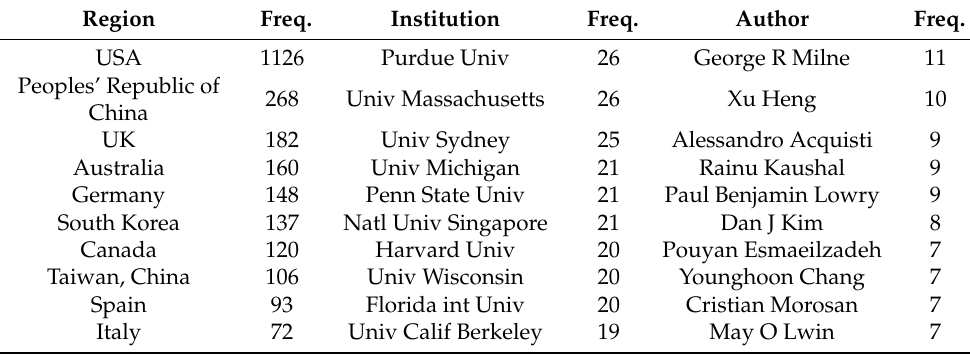
Table 1. Most prolific regions, institutions and authors in consumer privacy research. Region Freq. Institution Freq. Author